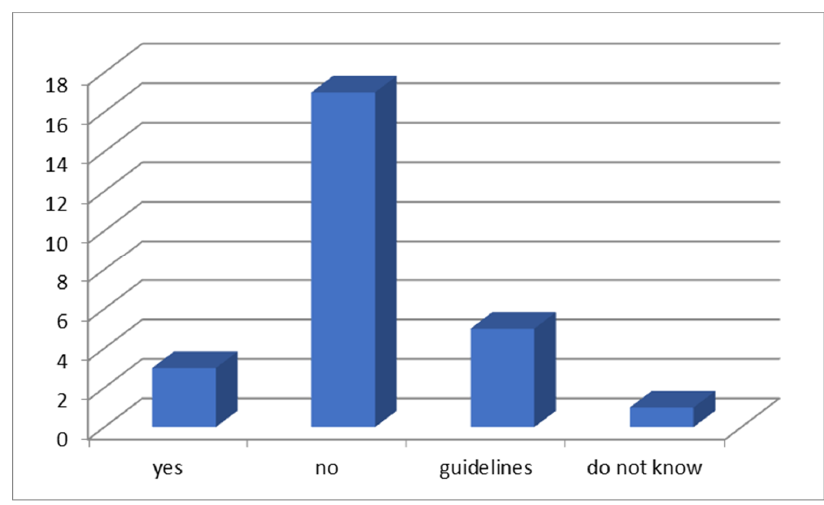
/ norms supporting the implementations of WrGIs / SuDSs. Figure 5. Presence of regulations/norms supporting the implementations of WrGIs/SuDSs. Figure 5. Presence of regulations